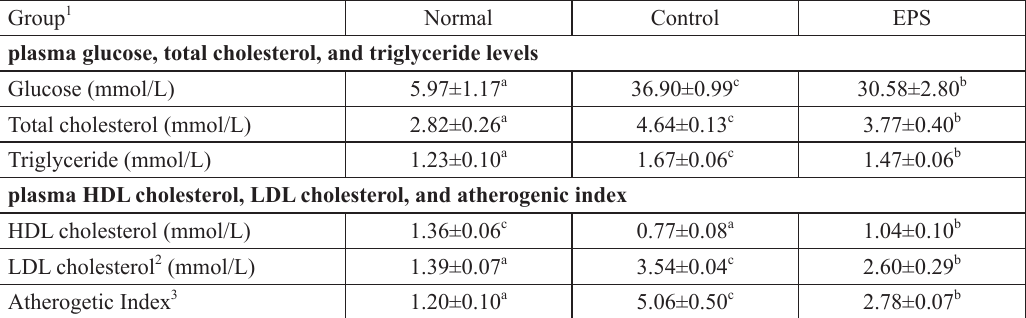
1 See Table I. 2 Total cholesterol - HDL cholesterol - (Triglyceride/5). 3 (Total cholesterol - HDL cholesterol)/ HDL cholesterol. Each value is mean ± SE for 8 mice. a,b,c Values with different superscript letters in the same column significantly different among the groups at